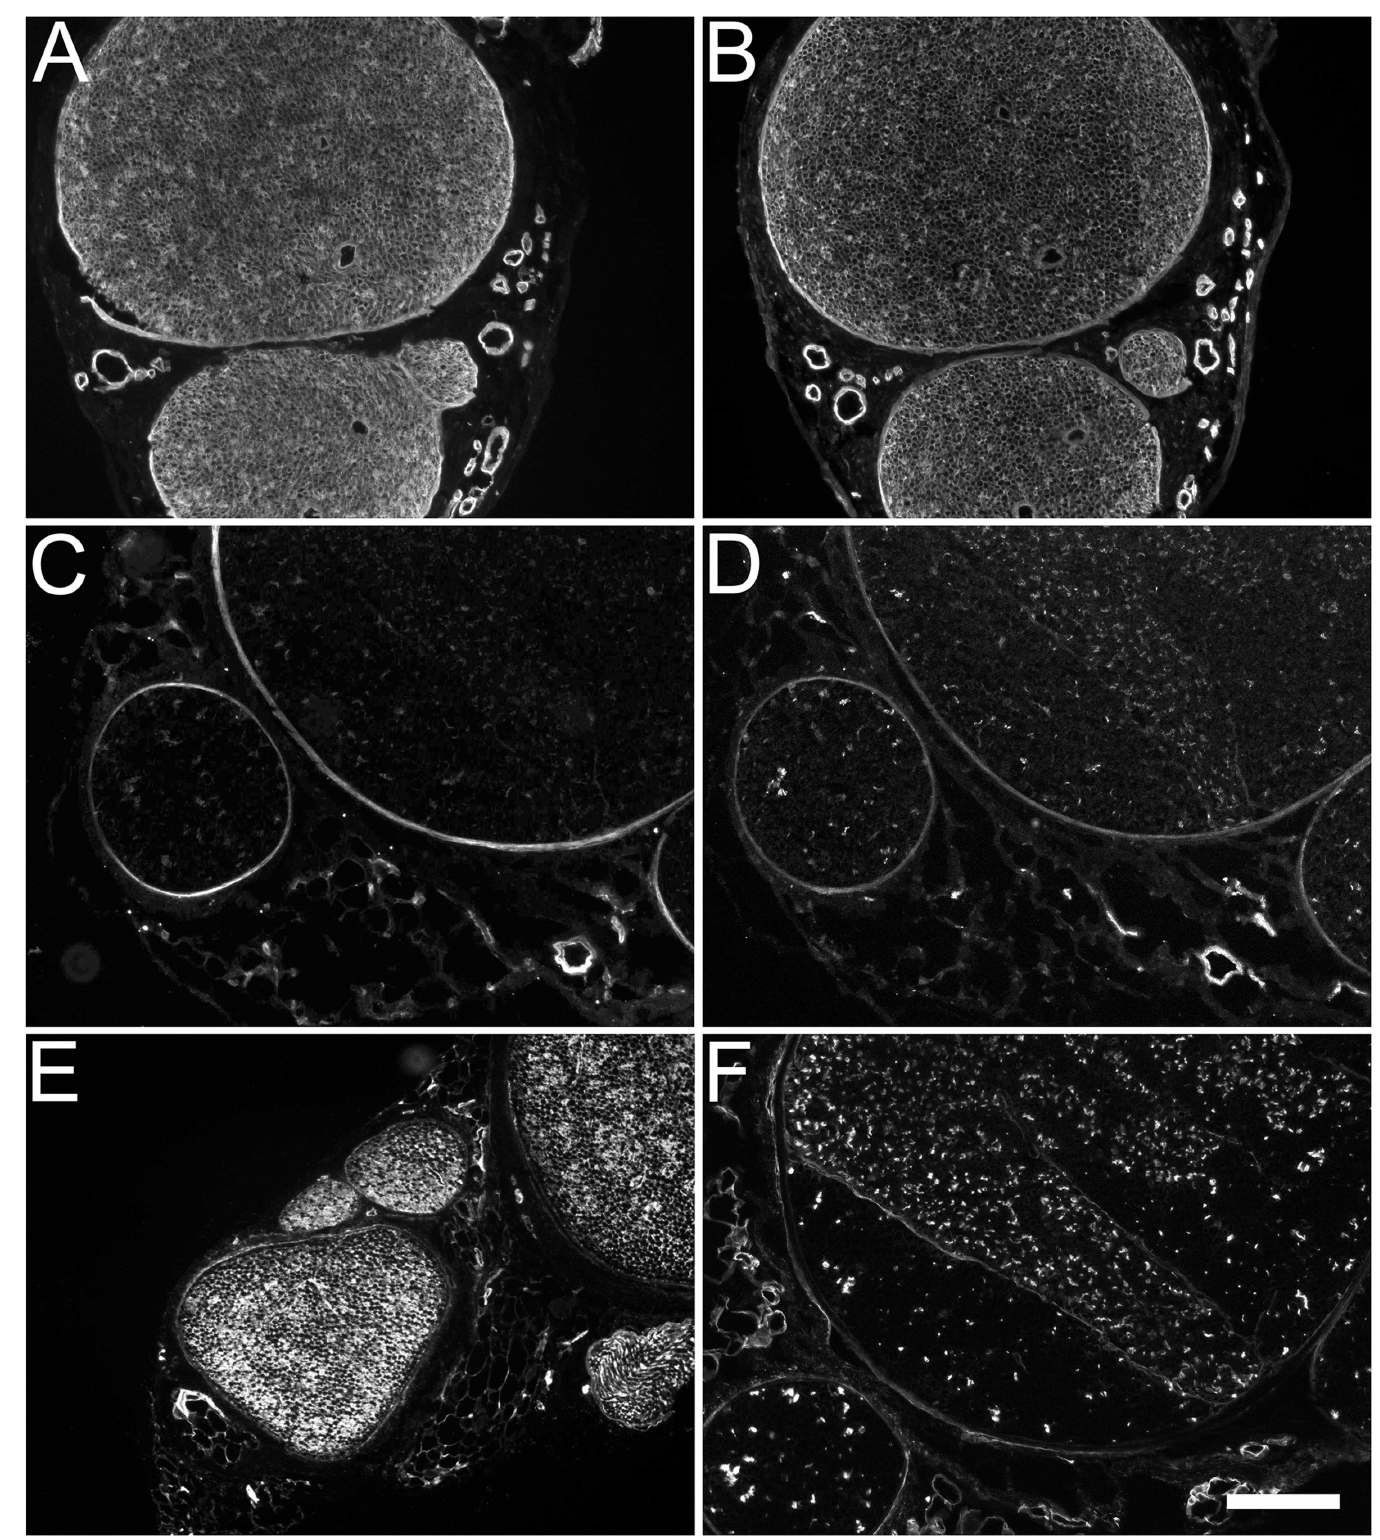
Fig 1. Distribution of proteoglycans relative to laminin in normal rat and rabbit peripheral nerve. Normal rat (A and B) and rabbit (C,D,E,F) sciatic nerve was subjectedto immunohistochemicalanalysiswith antibodiesagainstlaminin-2(A), proteoglycan core proteins (B,C,D) and glycosaminoglycan